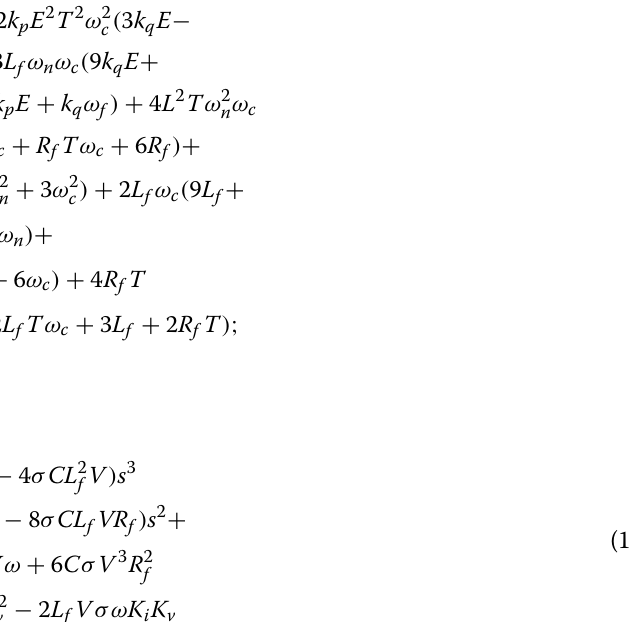
parison to the other approaches, the negative real parts